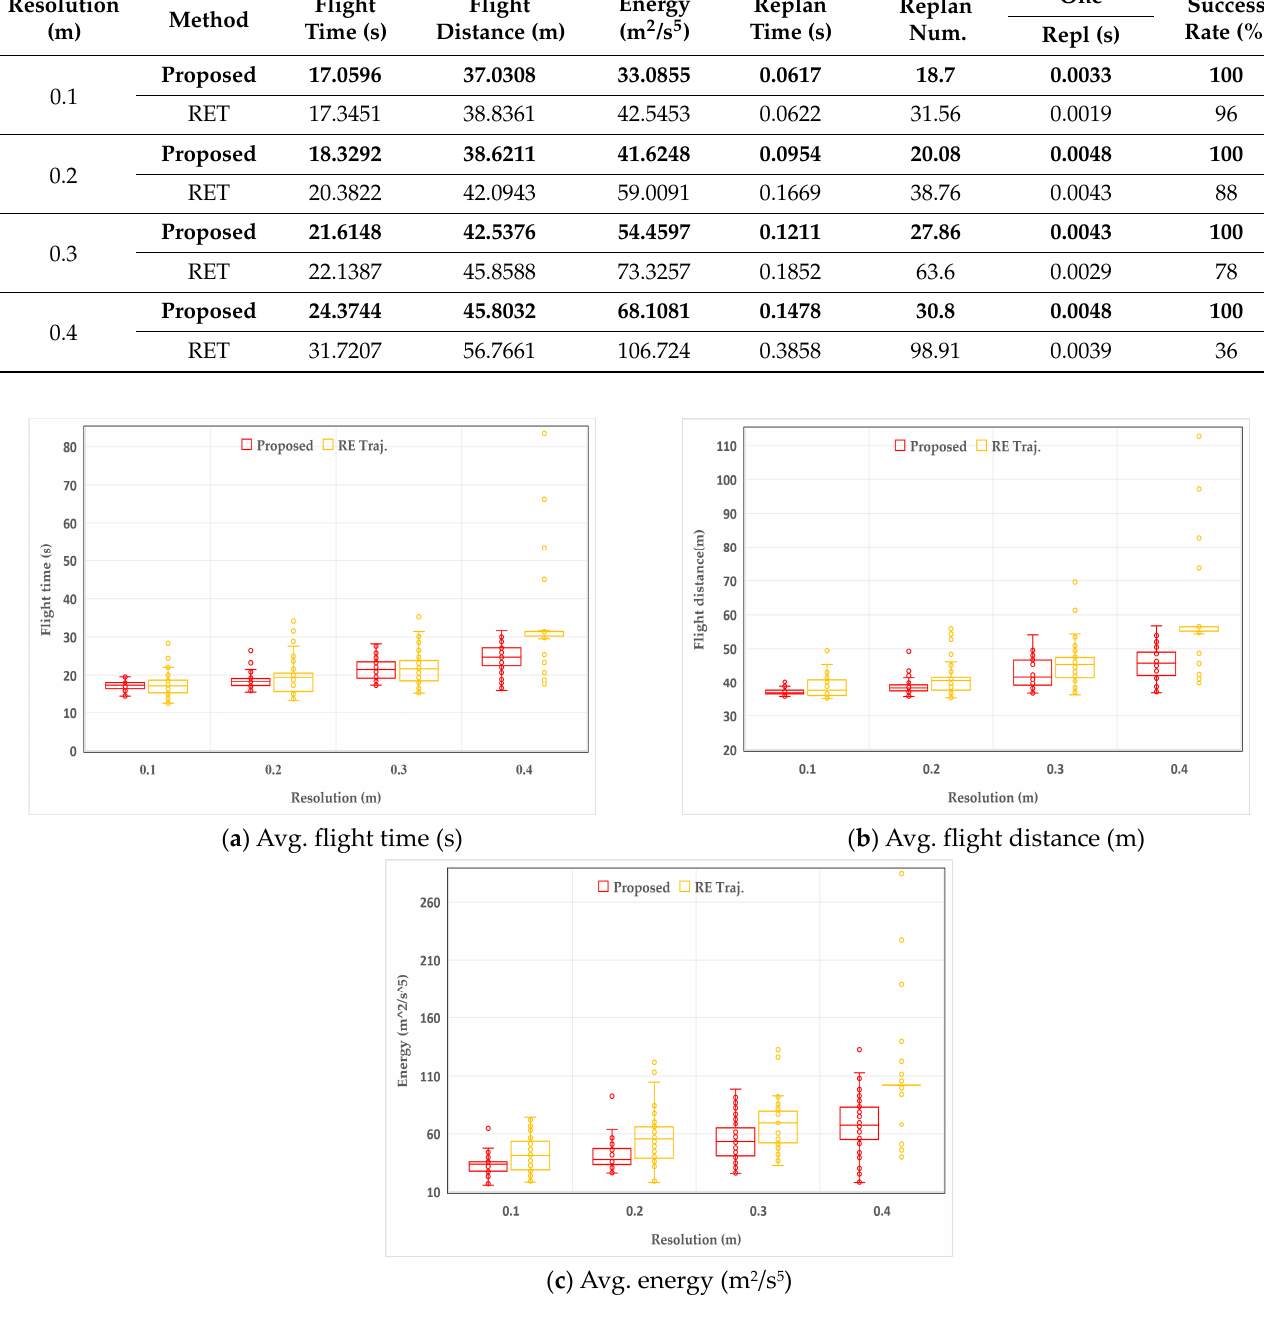
Table 3. The comparisons of the proposed method and no-opt. Density (obs./m 2 )